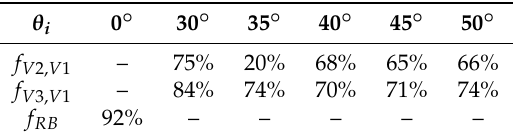
Table 4. Global accordance of models V2 and V3 with the measurements ( V1 ) expressed in f A , B . The global accordance of the reference beams ( f RB ) of the physical and virtual (VGP) illumination system is given for